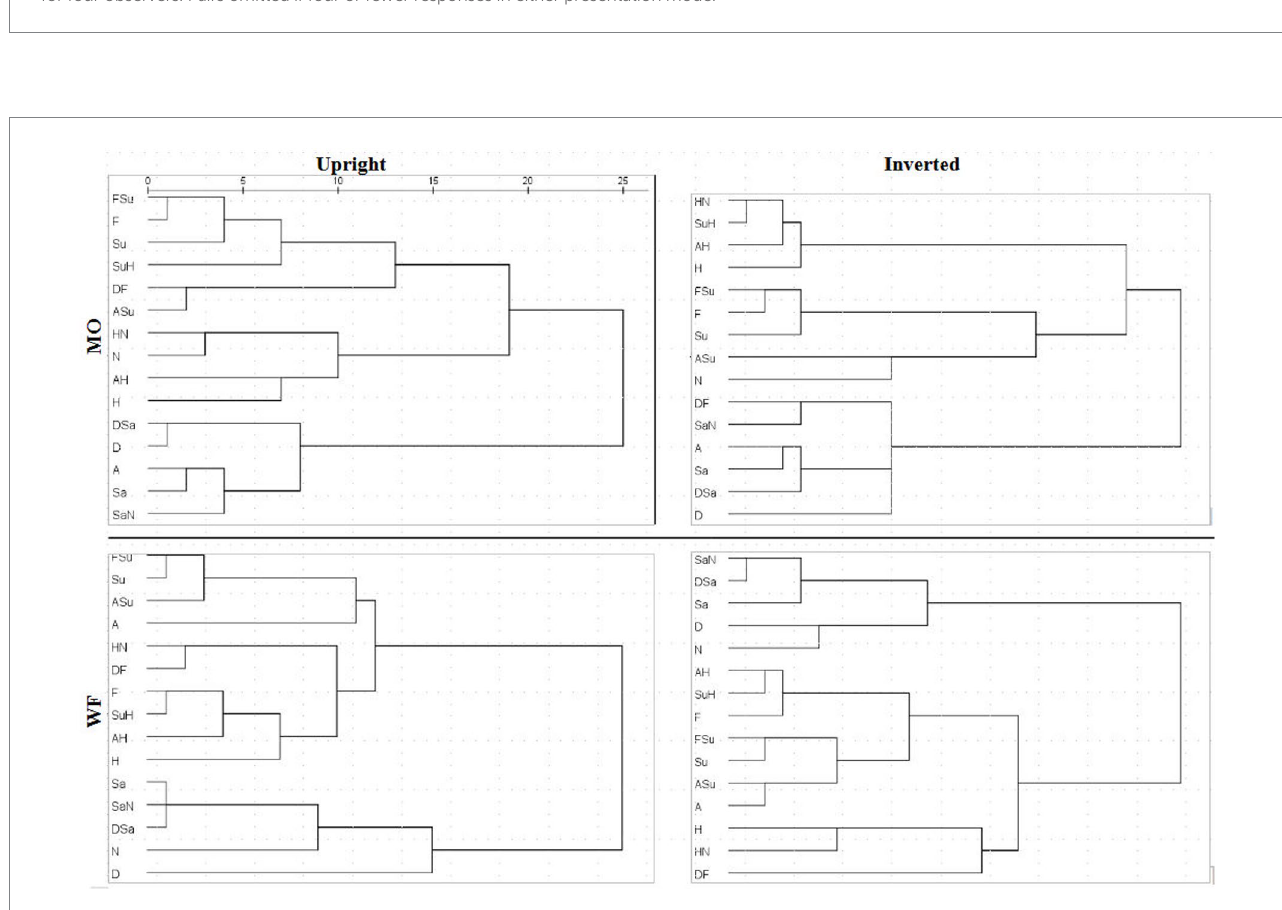
FIGURE 9 Dendrograms derived from MDS solutions for median RT*( i , j ) for MO series (upper row) and WF series (lower row), Upright (left) and Inverted (right).